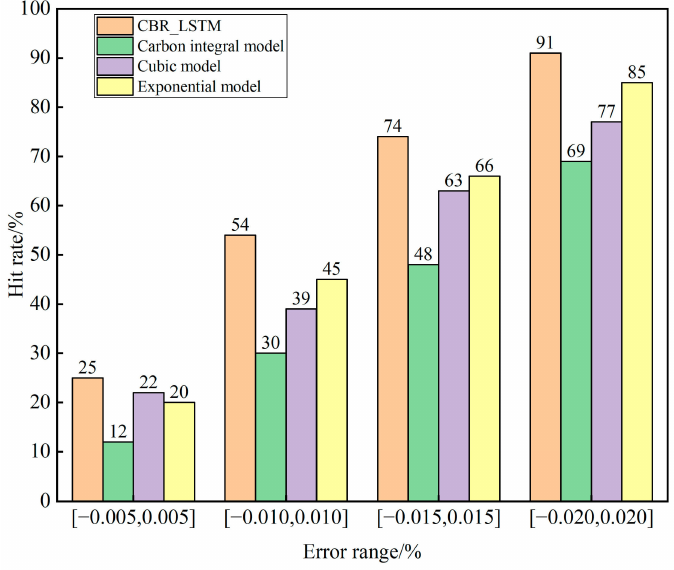
Figure 15. Prediction accuracies of each